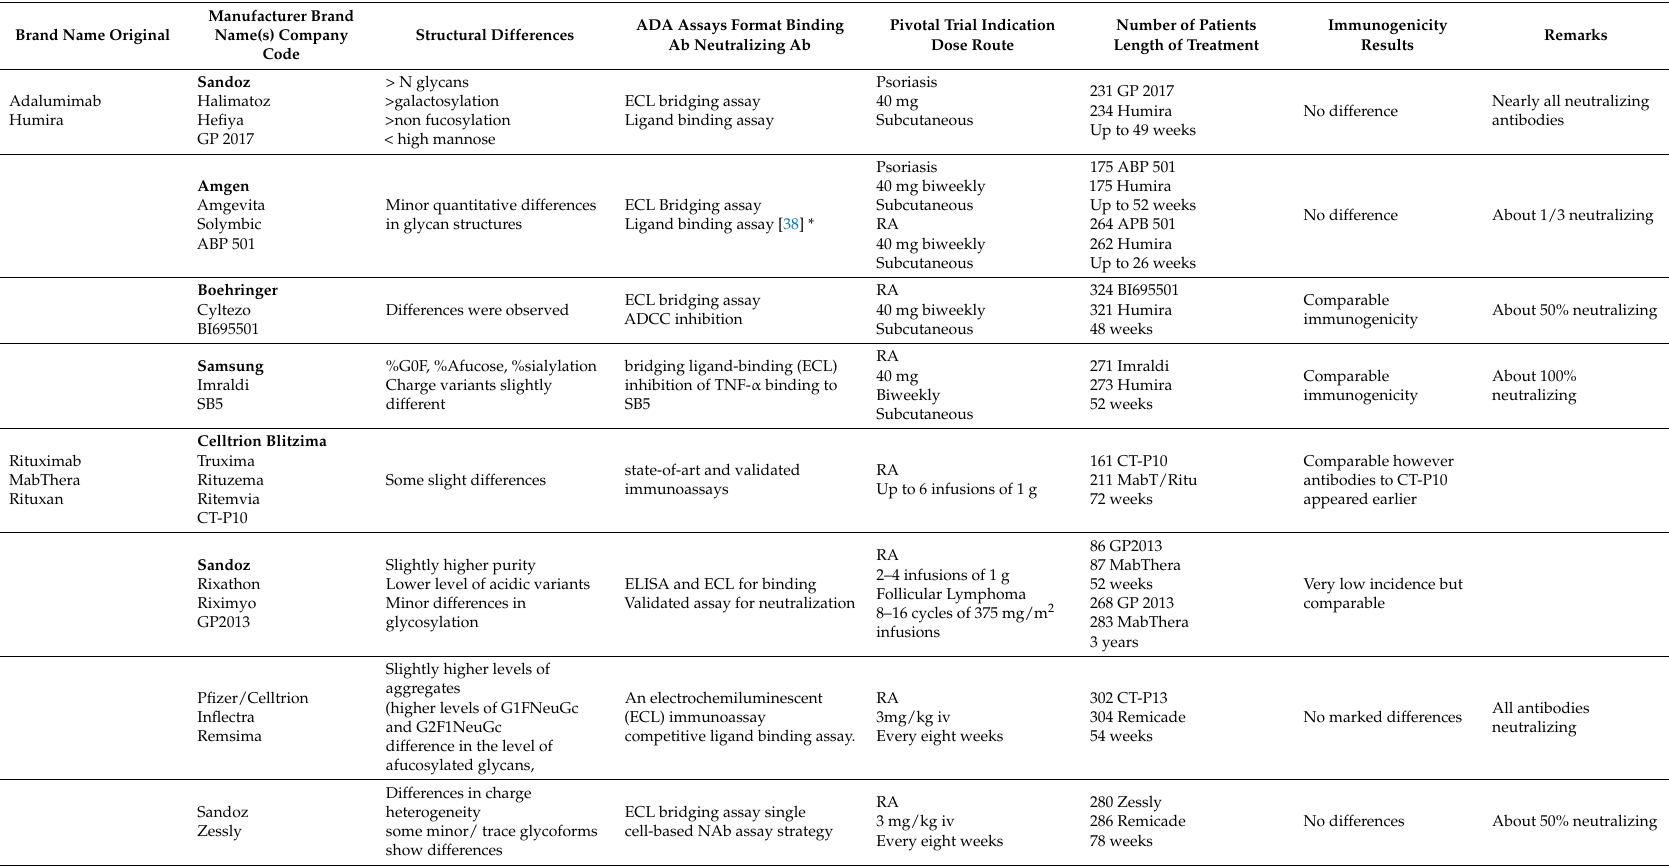
Table 1. Relative immunogenicity of biosimilar monoclononal